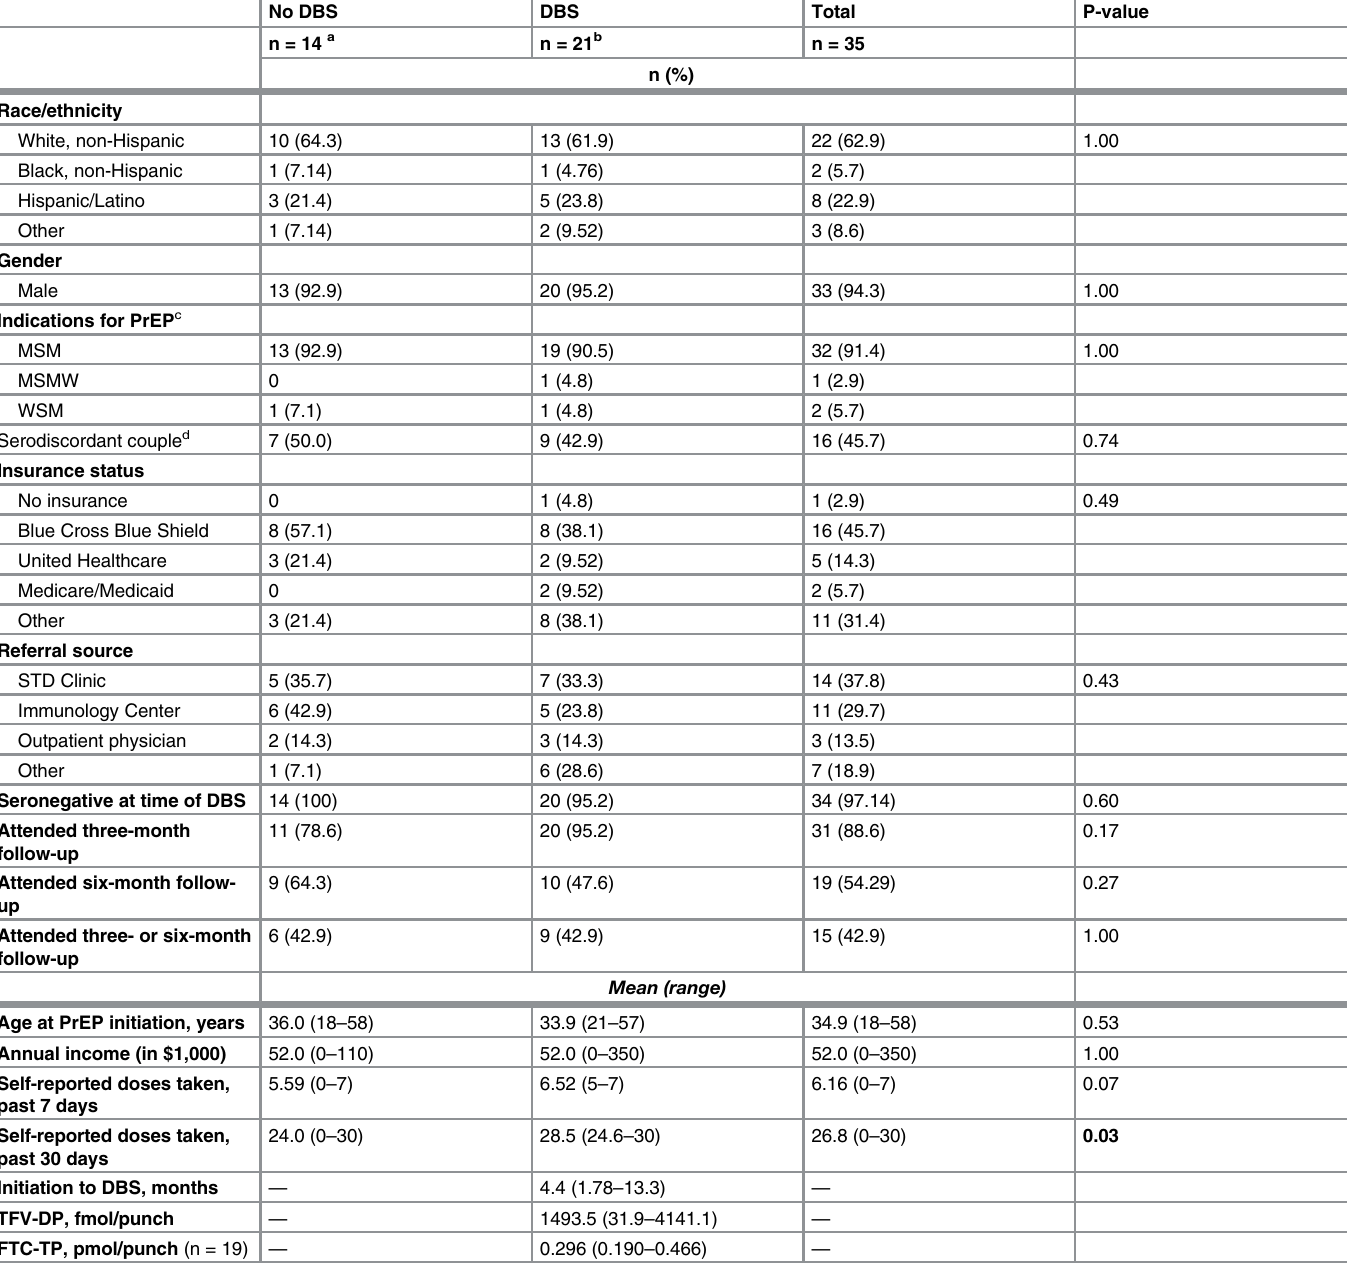
Table 1. Drug adherence and characteristics of patients with and without dried blood spots (DBS) who were retained in PrEP care at three and six months. No DBS DBS Total n = 14